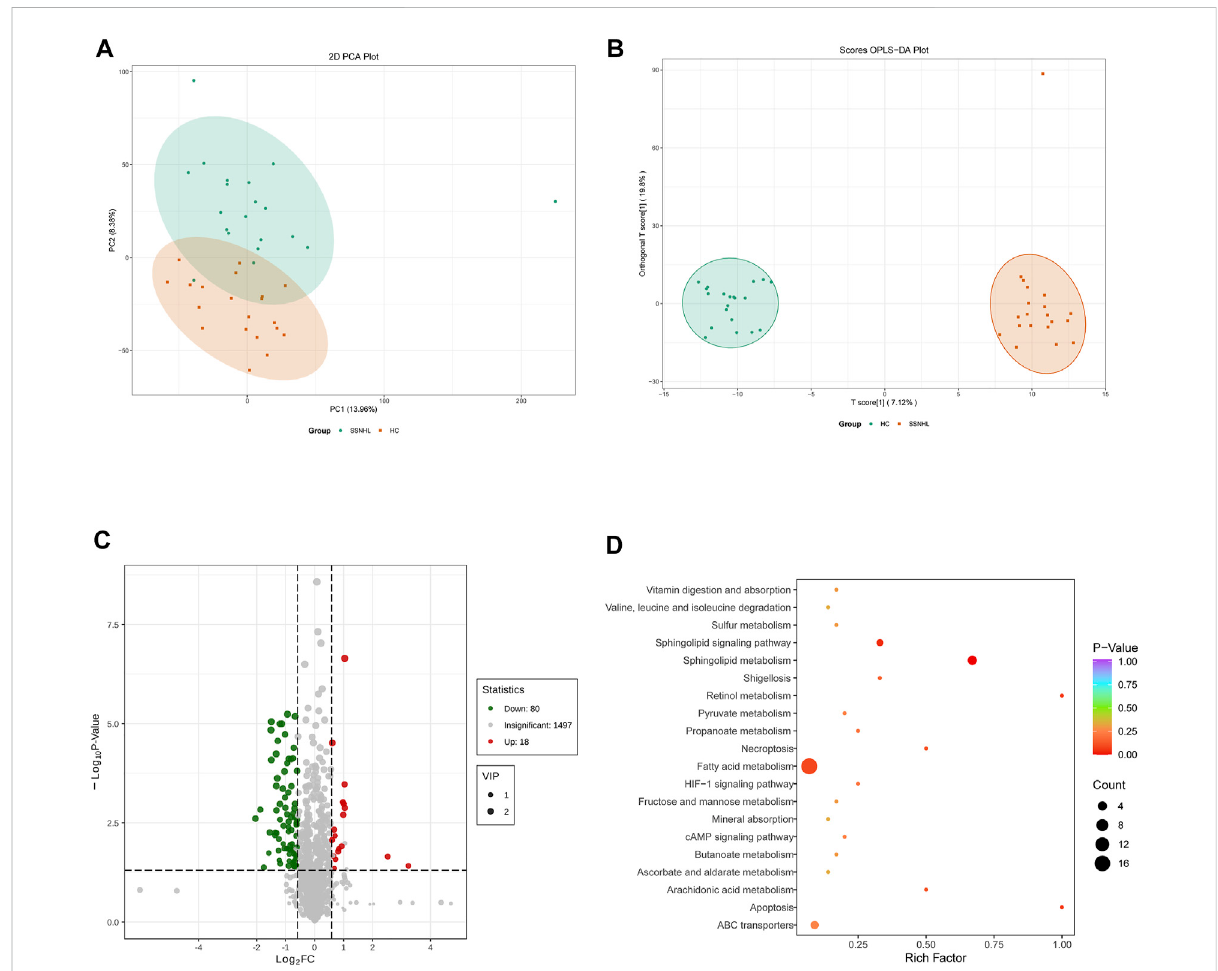
FIGURE 1 Serum metabolomics analysis of samples from SSNHL and HC groups. (A) PCA model and (B) OPLS-DA showed signi fi cant discrimination of SSNHL patients from HCs based on serum metabolomic pro fi le; (C) volcano plot of differentially expressed metabolites; (D) bubble plot of enriched metabolic pathways. SSNHL, sudden sensorineural hearing loss; HC, healthy control; PCA, principal component analysis; OPLS-DA, orthogonal partial least square-discriminant